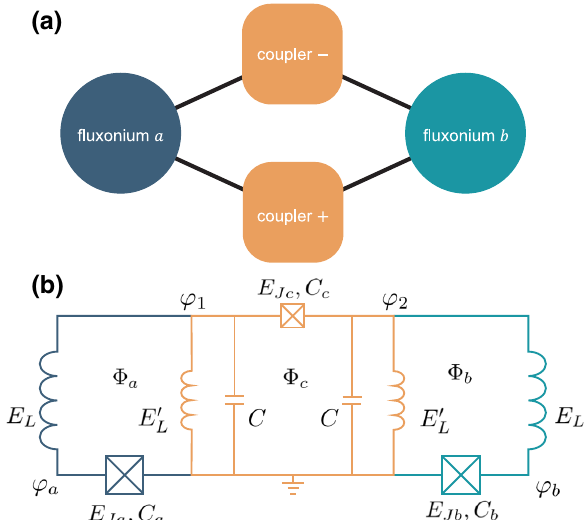
FIG. 1. Galvanically-coupled heavy-fluxonium qubits. (a) A schematic of the qubit-coupler interaction. The fluxonium qubits a and b are each coupled to a harmonic coupler mode θ + and a flux-tunable coupler mode θ − but do not interact directly. (b) The circuit diagram of the device. Qubit a (dark blue) and qubit b (light blue) are galvanically linked to the two coupler modes θ ± (orange). Each loop can be threaded by an external flux